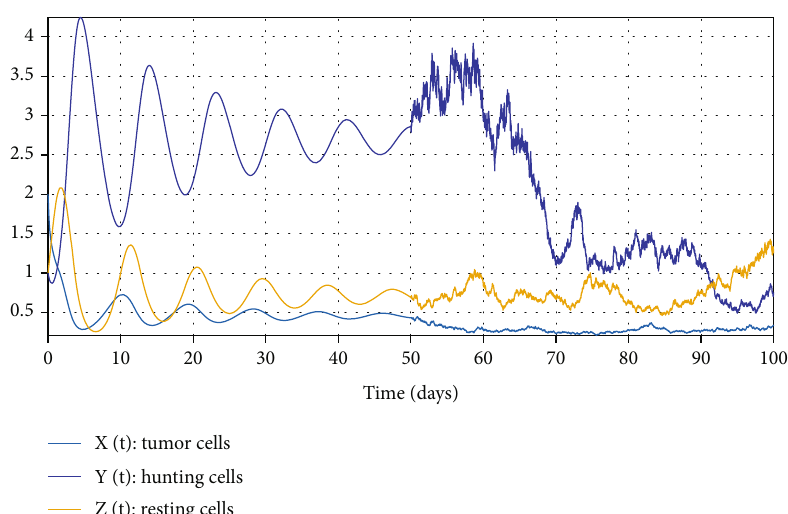
= 0 : 9 , c = 0 : 65 , c = 0 : 21 , c = 0 : 55 , c = 0 : 52 , c = 0 : 39 , c = 1 2 3 4 5 6 7